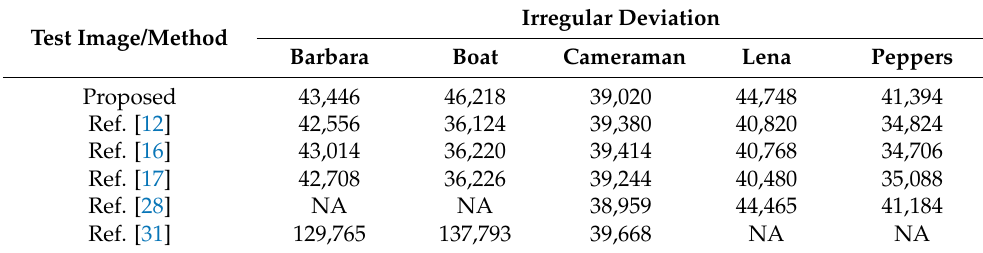
Table 6. Irregular Deviation.